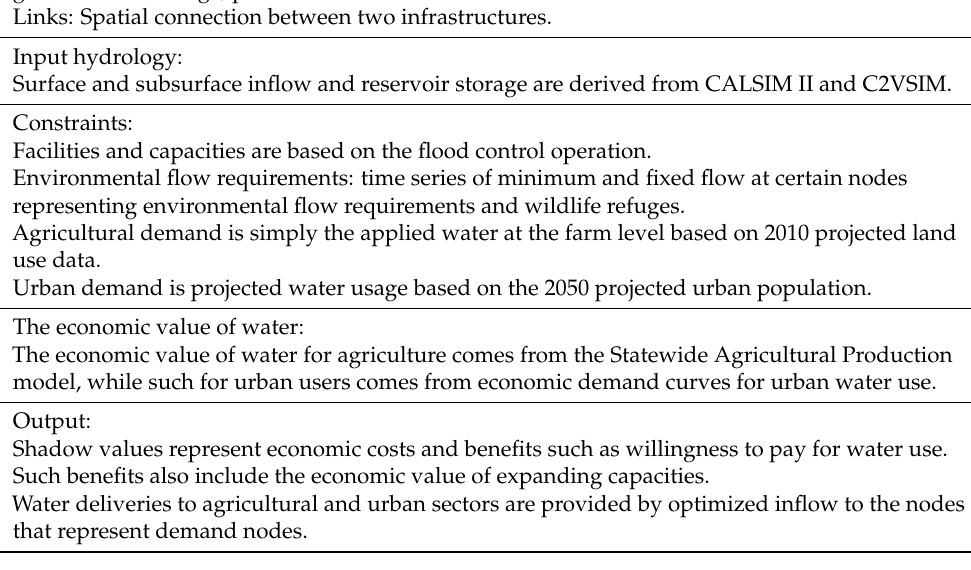
Table 1. Metadata related to CALVIN configuration and fundamental input and output to the